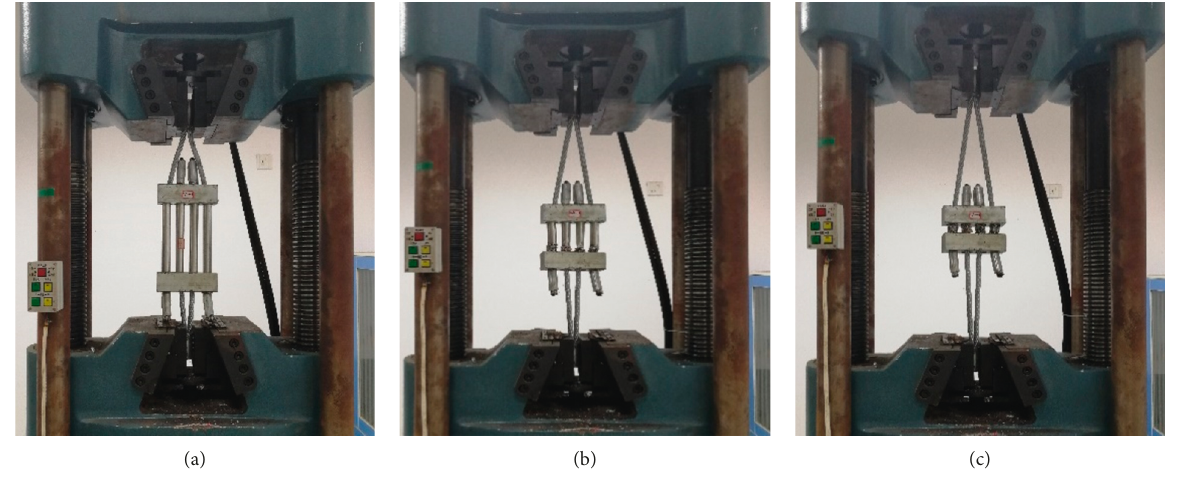
Figure 8: The quasistatic tensile process of the symmetric tube-crushing dissipator.